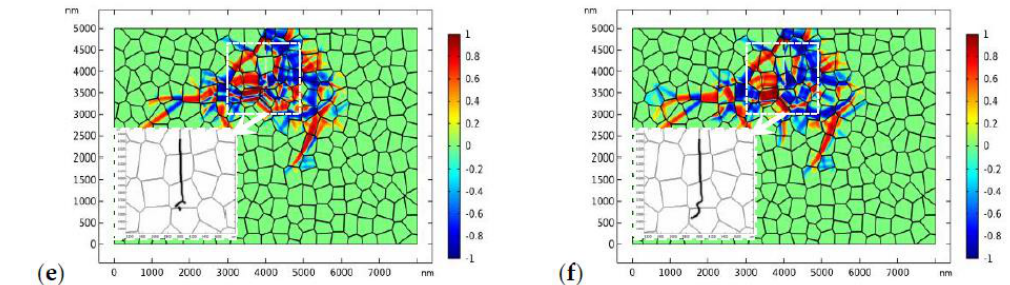
Figure 13. The evolution of the phase transformation and crack propagation in TZP (crystal orientation II) with a “strong” GB (plots represent η 1 − η 2 , and the crack phase is displayed in the amplified window separately), where the applied load is 150 MPa: ( a – f ) at times 0.4, 3.0, 3.5, 4, 5.0, and 5.5 µ s, respectively.